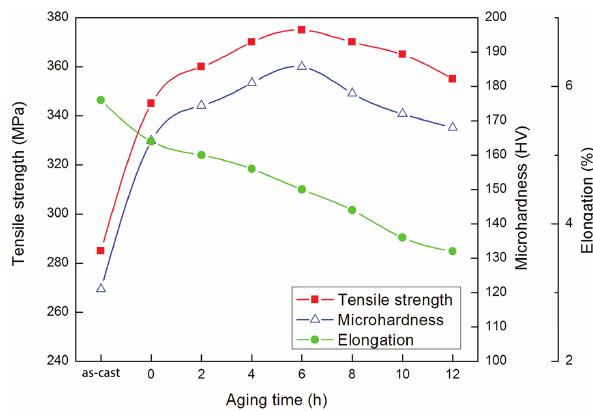
Figure 4: Mechanical properties of Al-Si-Cu-Mg alloys under different aging time.